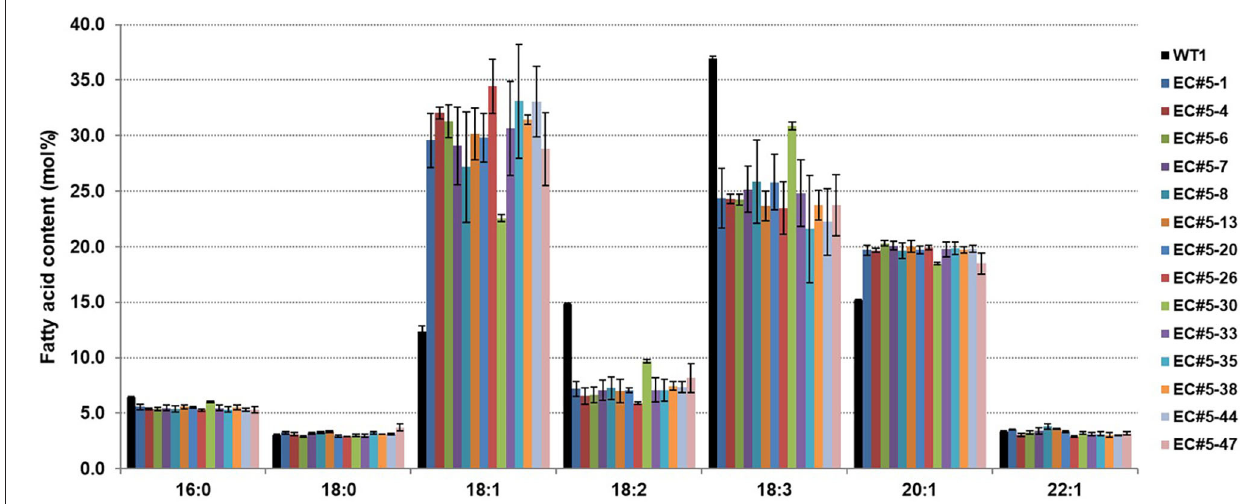
FIGURE 3 | CsFAD2 KO leads to substantial changes in fatty acid composition of Camelina seeds. Total PUFA contents are reduced and total MUFA contents are increased in CsFAD2 KO Camelina compared to the WT. Fatty acids whose contents were < 3% are not shown. Fatty acid analysis was performed in triplicate with different seeds, and error bars indicate the standard